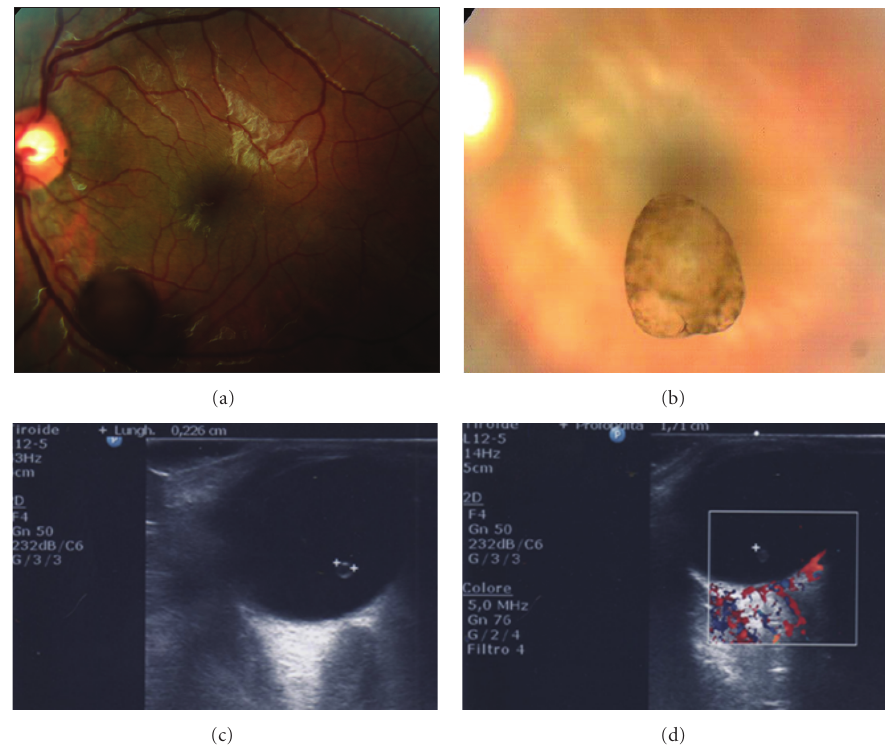
Figure 1: Ophthalmoscopy of the left eye shows a normal macula and a pigmented, oval-shaped cyst floating in the vitreous cavity and covering retinal vessels (a). The free-floating cyst was translucent, with a smooth brown-pigmented surface, and it was in the posterior vitreous (b). An oval-spherical hypoechogenic mass with thin hyper-reflective edges, with a 2.6-mm maximal diameter, was detected by real-time B-scan ultrasound of the left eye. The cyst was mobile in the posterior vitreous (c). Axial ultrasound with color Doppler showed no remnants of the hyaloid artery and no vessels in the vitreous of either of the globes, nor within the cyst